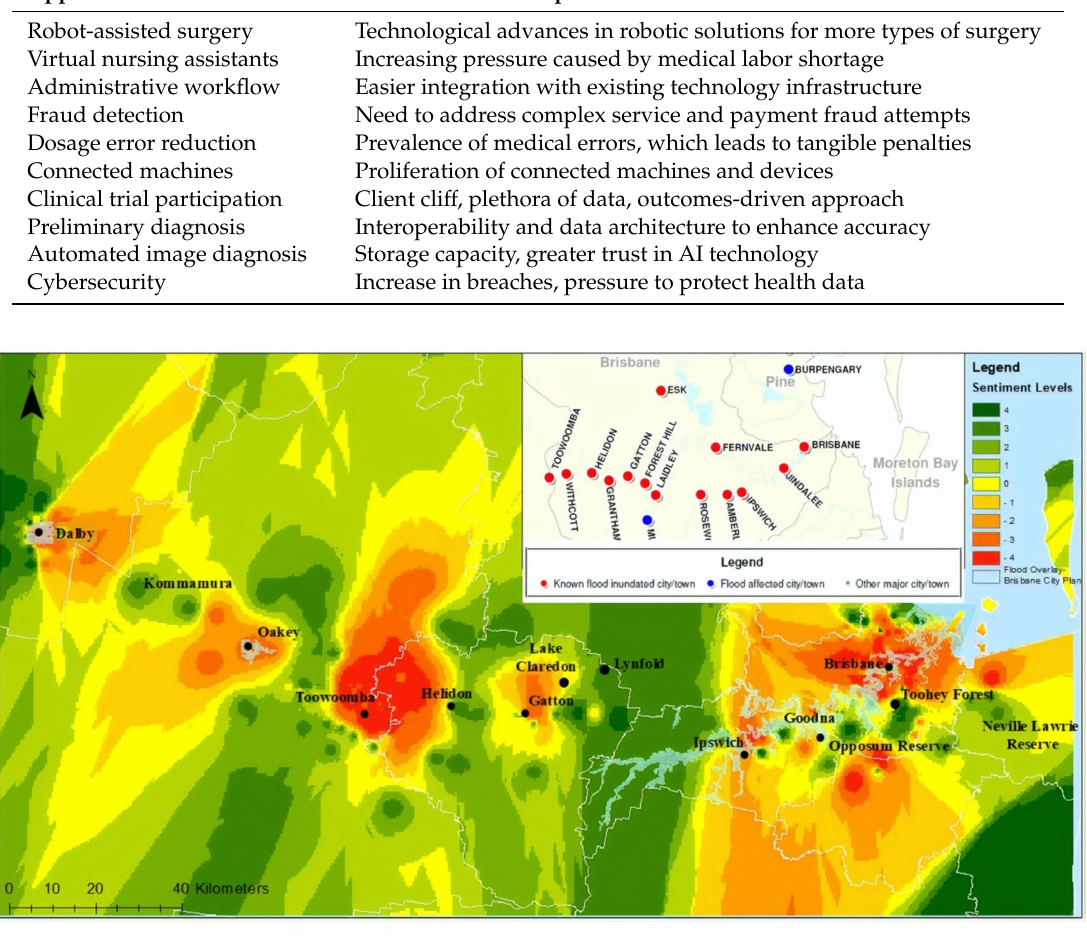
Figure 4. AI and big data analytics in natural disaster management, derived from Kankanamge et al.